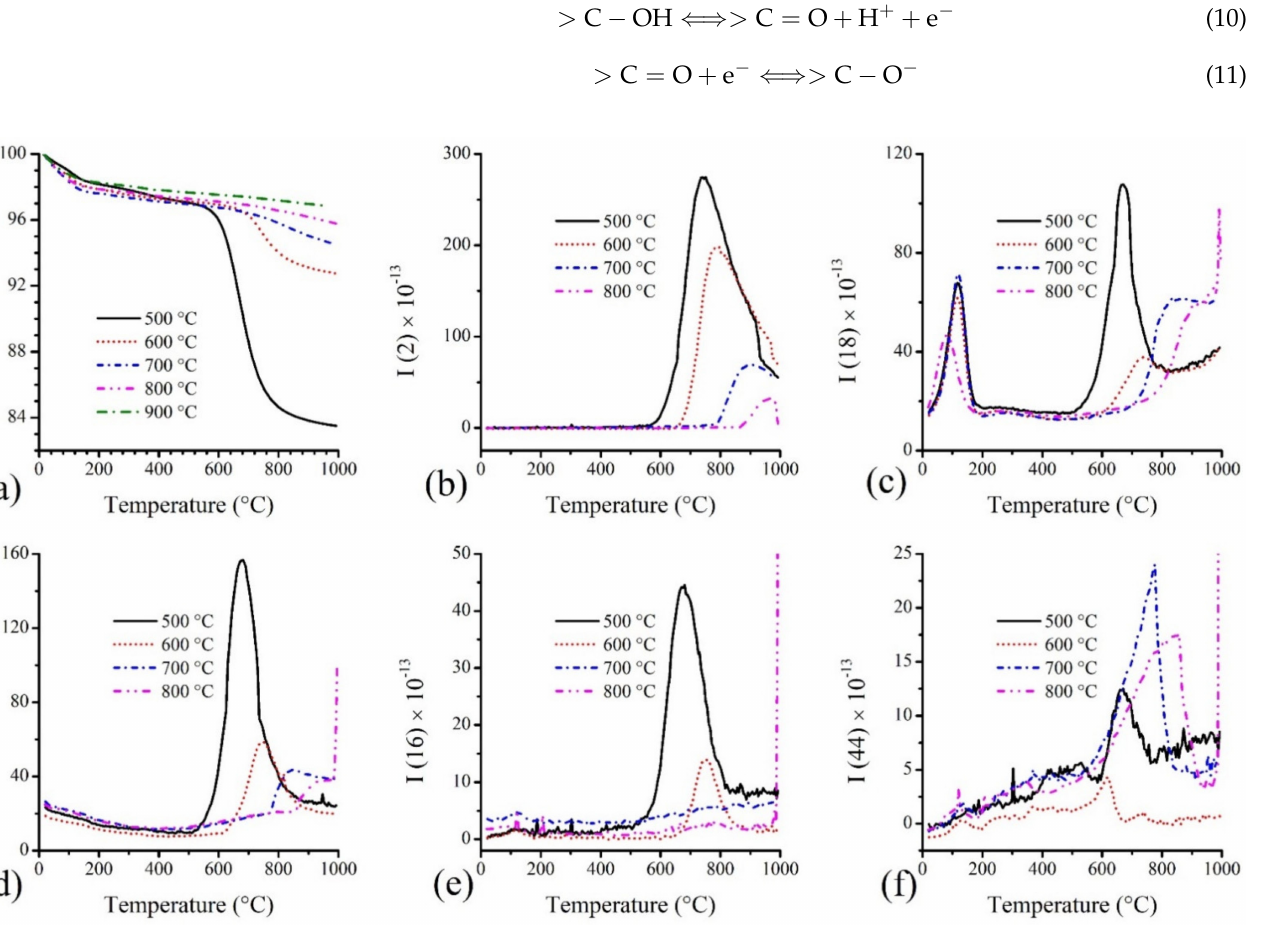
Figure 3. TG-MS curves of CXs obtained at different carbonisation temperatures: ( a ) TG curves and MS signals for ( b ) H 2 , ( c ) H 2 O, ( d ) CO, ( e ) CH 4 , and ( f ) CO 2